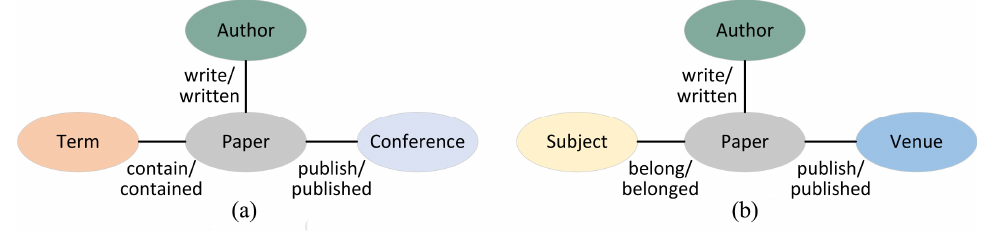
Figure 1. Academic citation heterogeneous graphs for ( a ) DBLP and ( b )